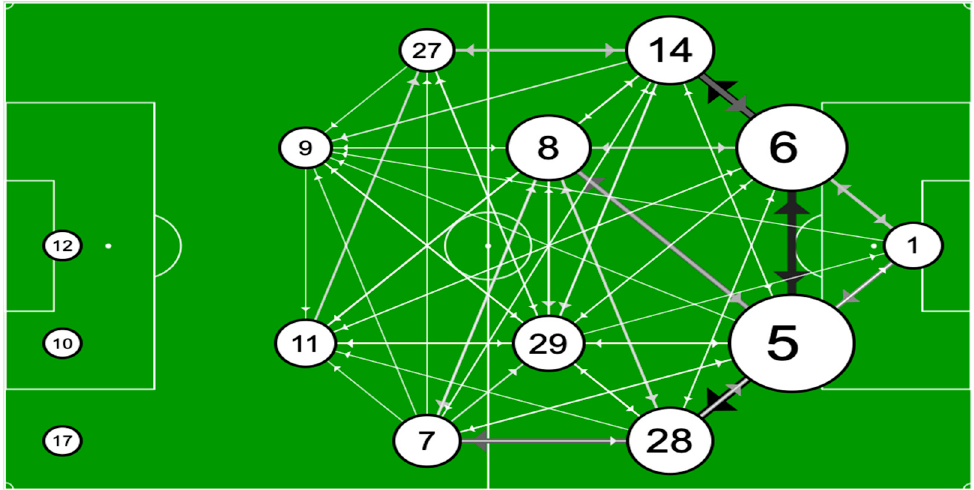
Figure 3. Network display results from team B in the first half of game